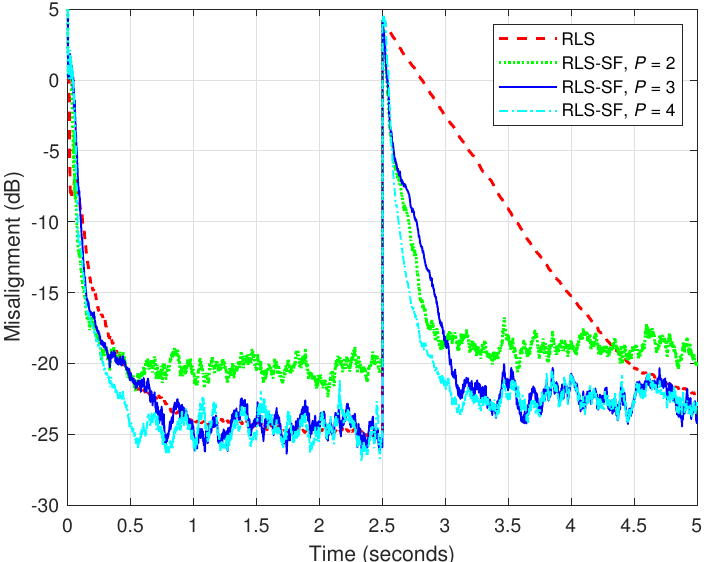
Figure 9. Performance of the conventional RLS filter [with λ = 1 − 1/ ( KL ) ] and the RLS-SF [with λ 1 = 1 − 1/ ( KPL 1 ) and λ 2 = 1 − 1/ ( KPL 2 ) ], using K = 10, for the identification of the network echo paths from Figure 1a,b. The input signal is an AR(1) process, SNR = 20 dB, and the echo path changes after 2.5